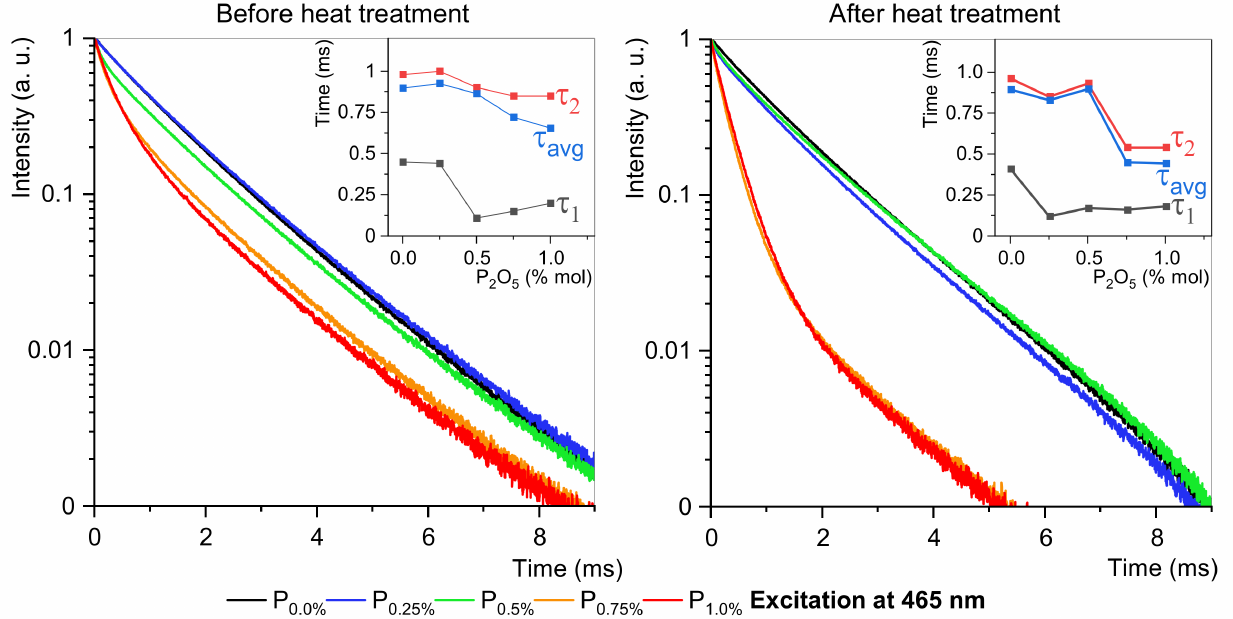
Figure 7. Luminescence decays and τ changes at 465 nm excitation. Lifetimes are in